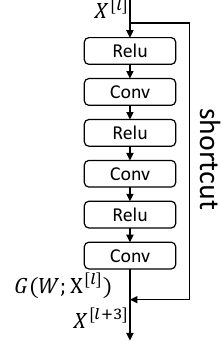
Figure 2. Improved residual